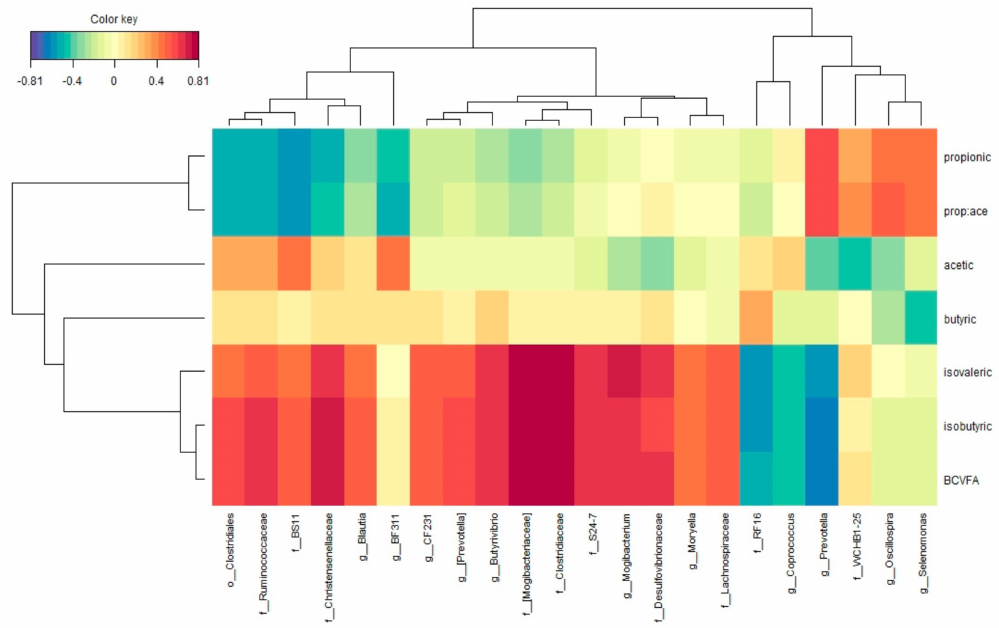
Figure 5. Relationships between clusters of bacterial genus and rumen VFA proportions independent of treatment ( n = 35). This clustered image map was based on the regularized canonical correlations between relative bacterial abundances and relative concentrations of rumen volatile fatty